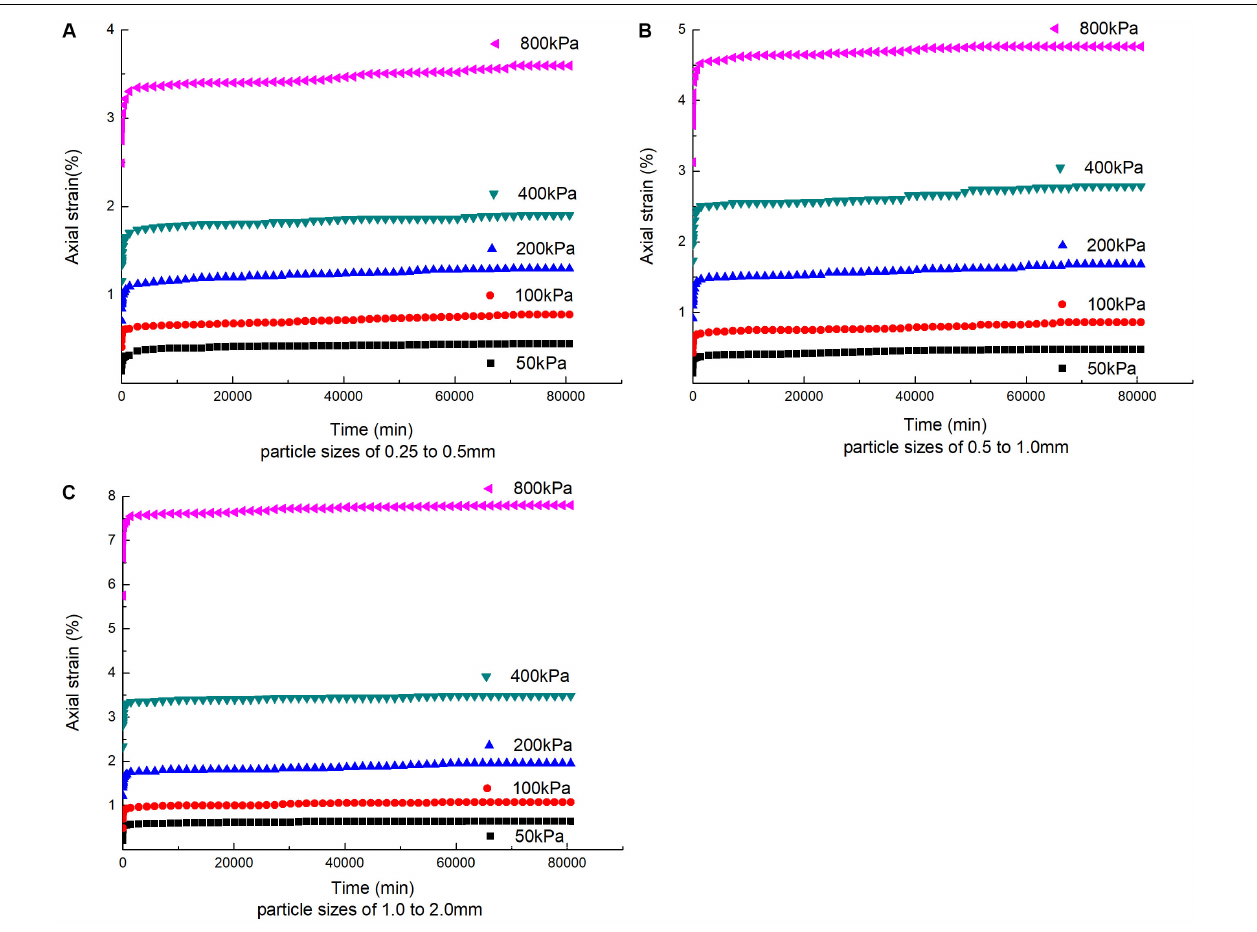
FIGURE 5 | Axial strain-time relationship curves of coral sand with different particle sizes. (A) Particle sizes of 0.25–0.5 mm, (B) particle sizes of 0.5–1.0 mm, and (C) particle sizes of 1.0–2.0